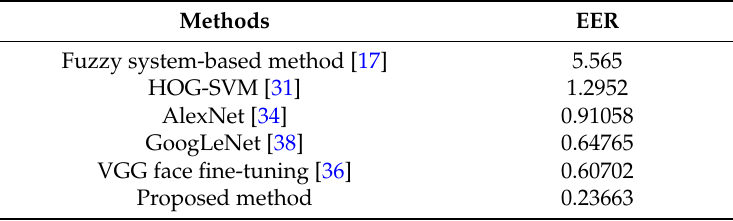
Table 7. Summarized comparative errors for our method and the other methods (unit: %).